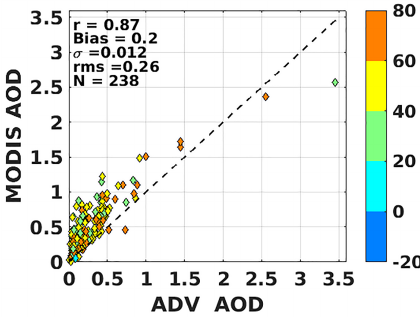
Figure 10. MODIS/Terra C6 merged DTDB AOD vs. AATSR ADV v2.31 AOD, for collocated AATSR-MODIS-AERONET data, as described in the text of Sect. 4.3. The colors (see scale on the right) indicate the difference between the MODIS/Terra and ATSR over- pass times in